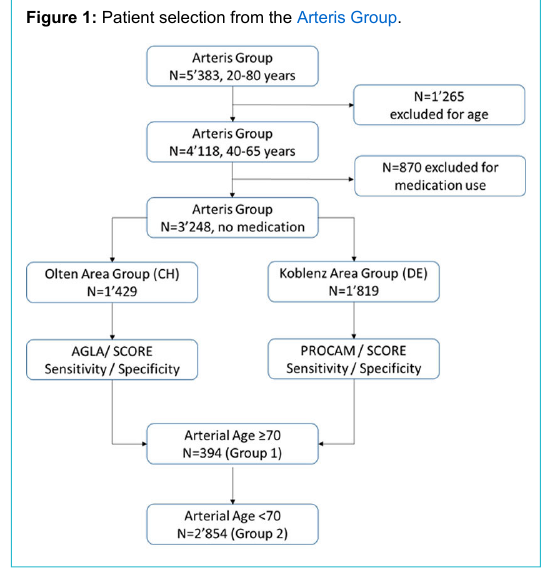
Figure 1: Patient selection from the Arteris